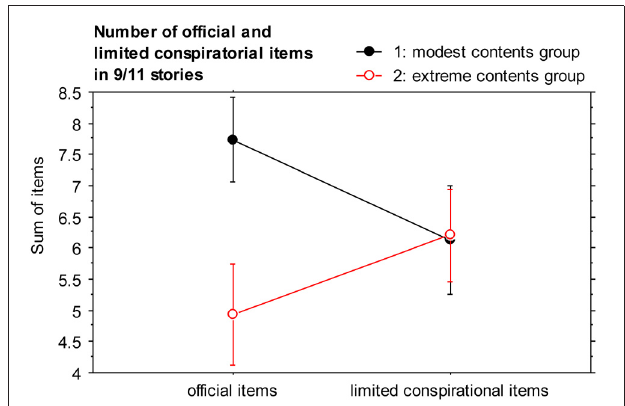
FIGURE 2 | Comparison of number of official and limited conspiratorial items for both experimental groups in the to be generated 9/11 stories. Error bars indicate ± 1 SEM (standard error of the